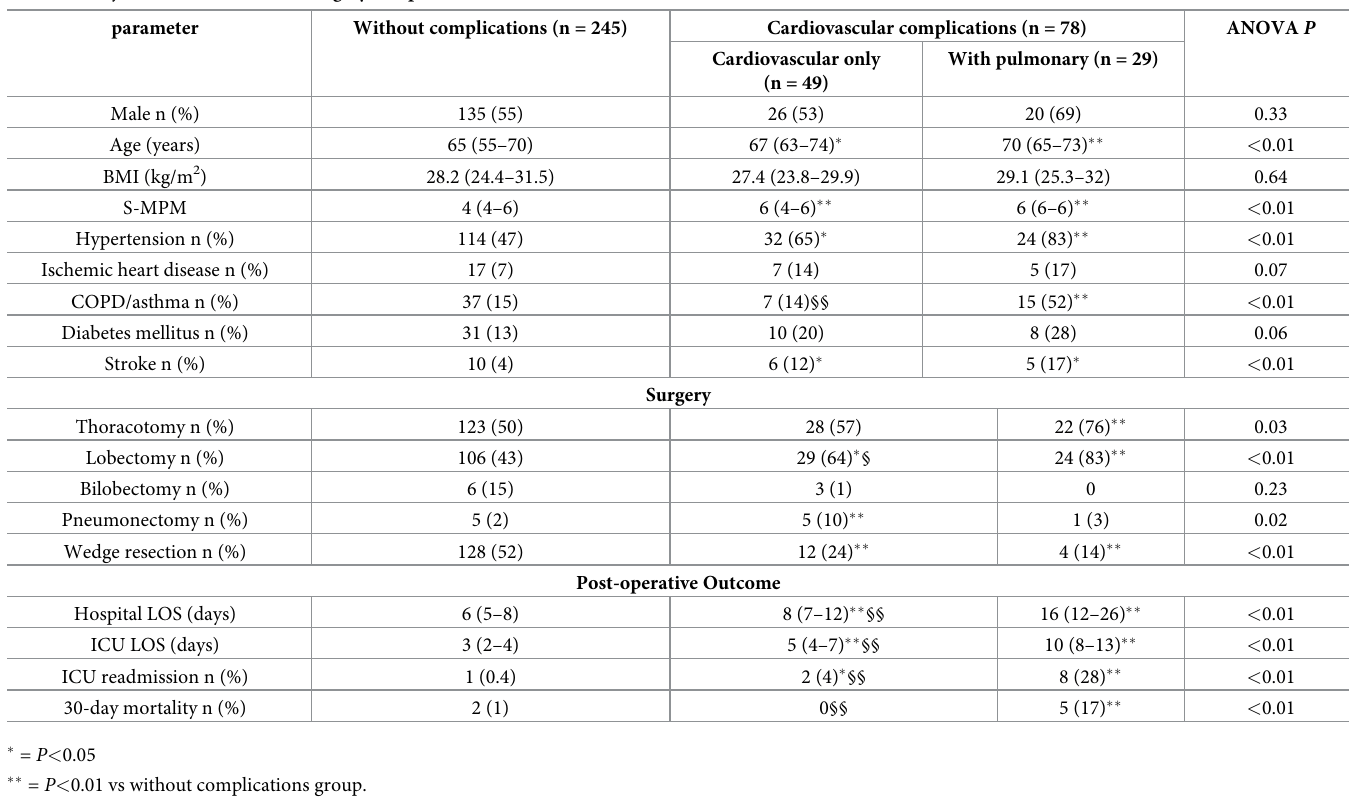
Table 2. Subject characteristics and surgery